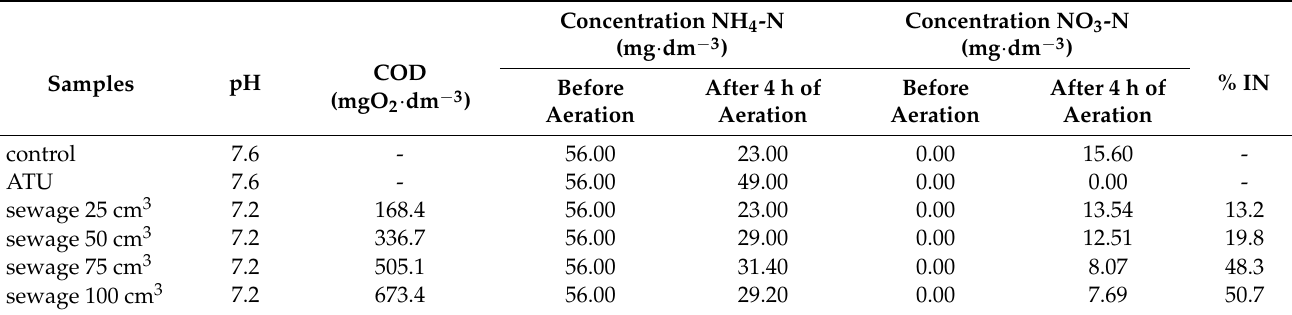
Table 4. Influence of COD of industrial wastewater from acrylonitrile rubber production on the nitrification inhibition in activated sludge under laboratory conditions.